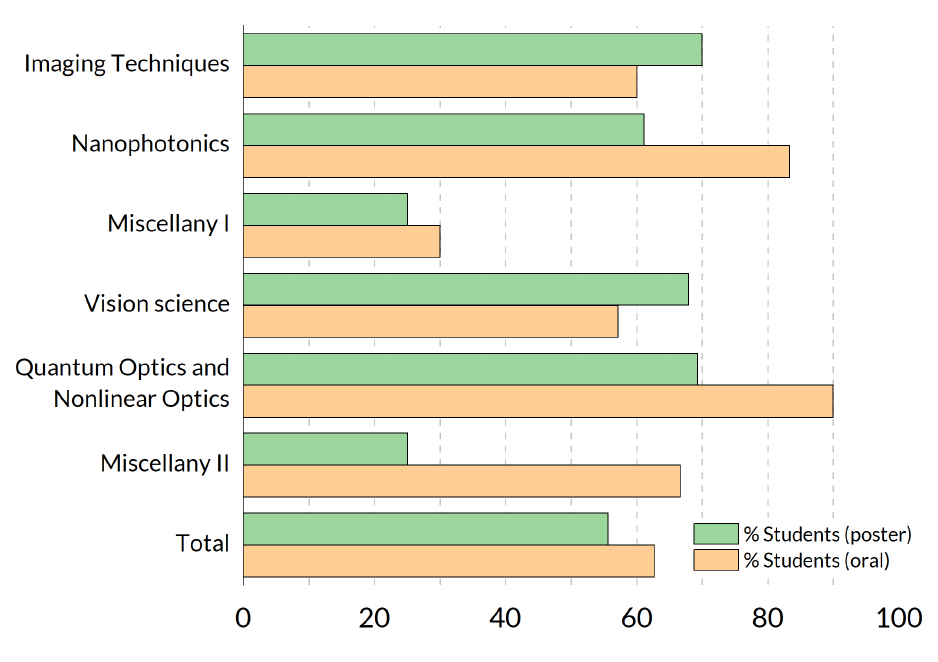
Figure 5. Percentage of students as presenting authors in posters and oral talks (by